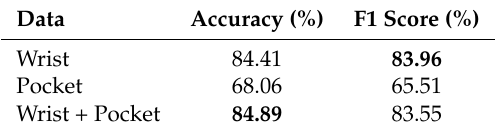
Table 6. CNNs’ accuracies and F1 scores. Boldface indicates the best results for each